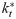
Real-time APE sensitivity to rapid epidemic control.We simulate 103 independent epi-curves under renewal models with (A) one effective and (B) two partially effective interventions. Top graphs give the true (green) and predicted (blue) incidence ranges, the middle ones provide estimates of Rs under the final kt* and the bottom graphs illustrate how successive ks* choices from APE can reliably and rapidly detect the impact of real-time control actions.